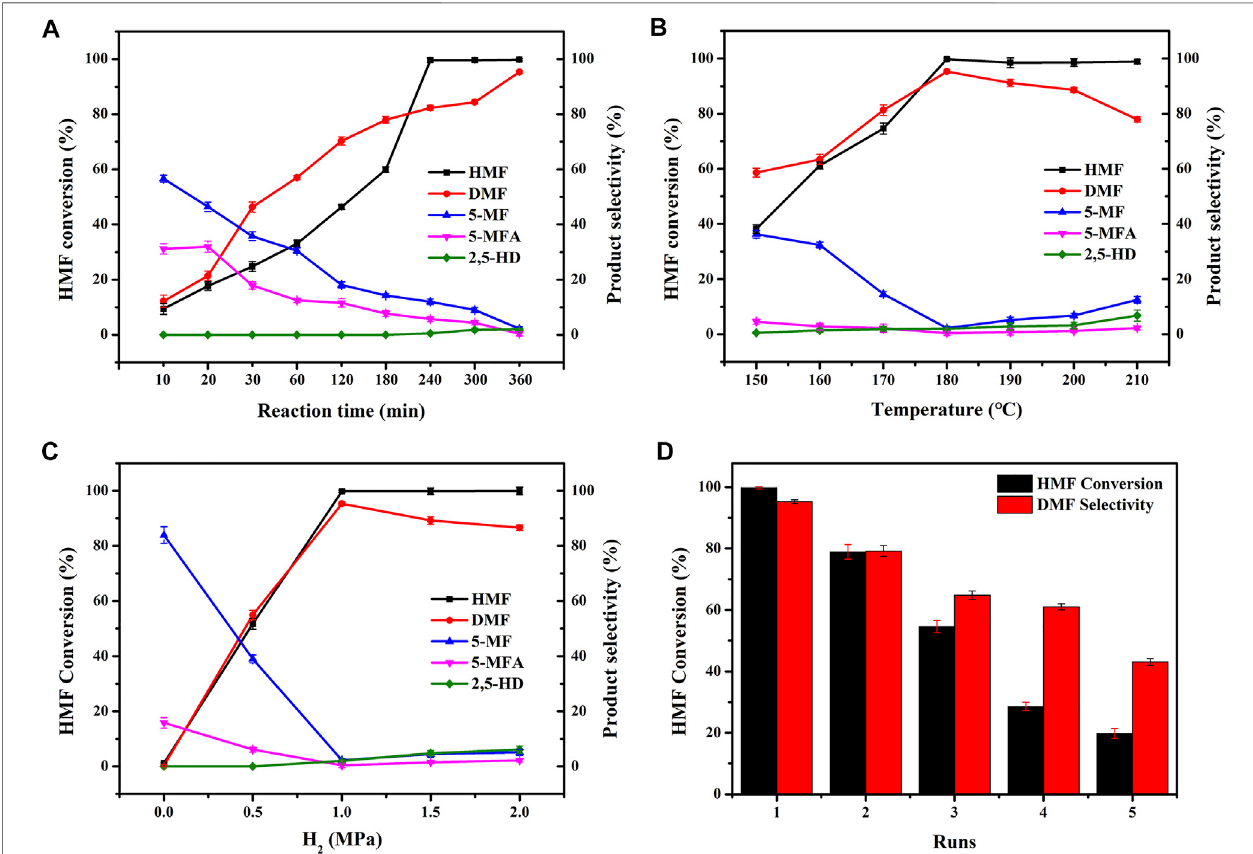
FIGURE 9 | Effect of (A) reaction time, (B) temperature, (C) H 2 pressure, and (D) catalytic test runs on the HMF hydrogenation performance of CuCoNiAl-MMO. Reactionconditions: (A) 0.1 gcatalyst,1.0 MPaH 2 ,0.25 gHMF,180 ° C (B) 0.1 gcatalyst,1.0 MPaH 2 ,0.25 gHMF,6 h (C) 0.1 gcatalyst,0.25 gHMF,6 h,180 °